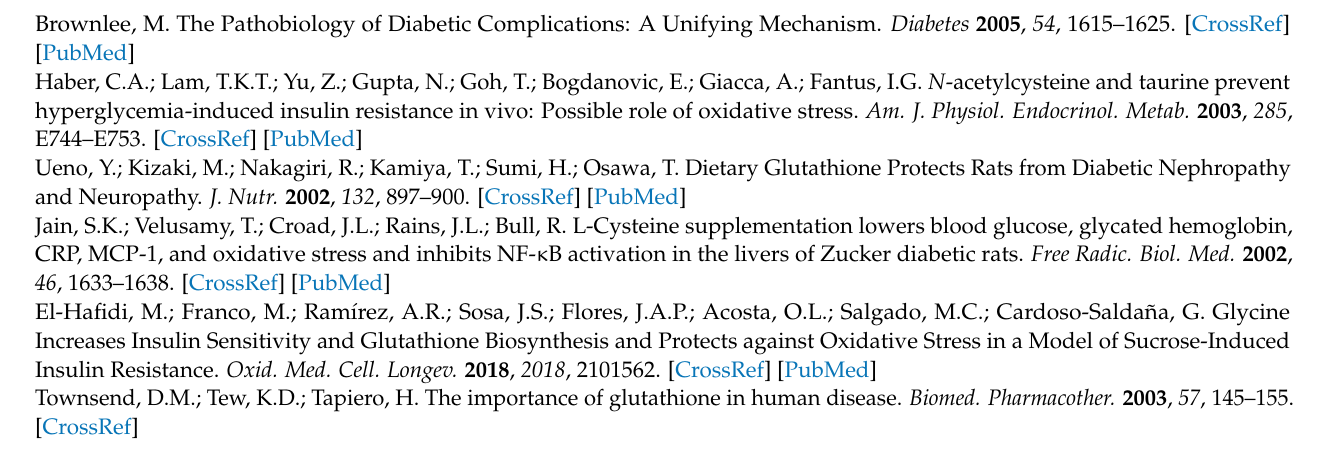
age. Figure S5: The effect size of changes in blood biochemical parameters of subjects younger than 55 years of age. Figure S6: The effect size of changes in blood biochemical parameters in (A) females and (B) males in the study. Figure S7: The effect size of changes in blood biochemical parameters, HOMA IR and HOMA β (A) between D and DG groups and (B) elder sub-groups of D and DG. Table S1: Summary of clinical trials conducted using GSH/different forms of GSH/precursors of GSH. Table S2: Number of subjects in (A) D and (B) DG groups with different types of anti-diabetic treatment. Table S3: Biochemical measurements at different visits in Control, D, and DG groups. Table S4: Inter-group comparisons of baseline